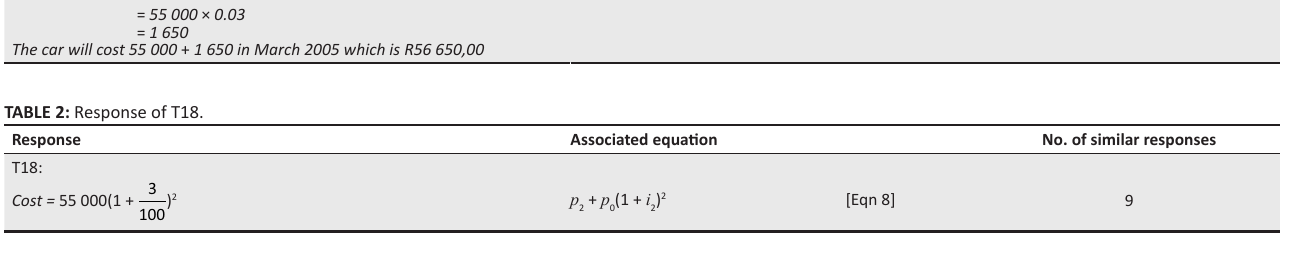
TABLE 3: Response of T35. Response